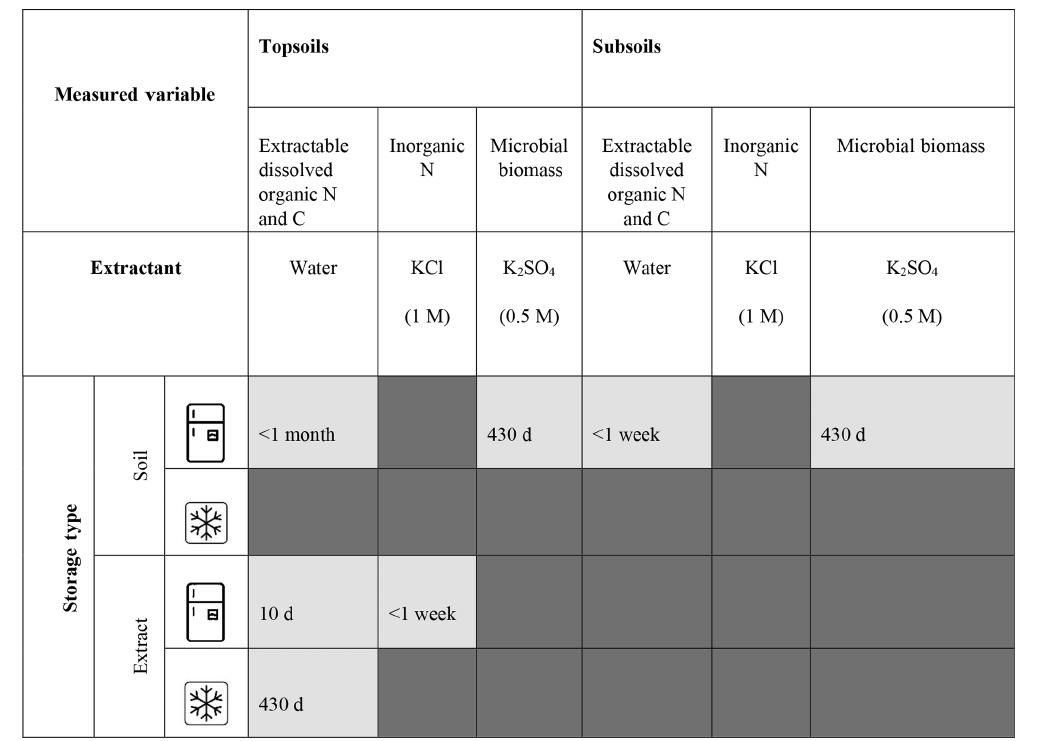
Table 2. Storage method recommendations for both temperate topsoil and subsoil. Dark grey denotes inappropriate storage methods for a specific analysis. Light grey denotes appropriate storage method, where storage length is annotated. Where storage length is annotated as 430d we are unable to advise storage length beyond this due to the length of the experiment. Storage methods are deemed appropriate: (1) if the storage method does not compromise the sample integrity (defined as stored samples yielding soil parameter values within 20% similarity limits to fresh samples) for both topsoils and subsoils explored; and (2) where the same extractant type is used to measure different parameters, the storage method does not compromise the integrity of each parameter